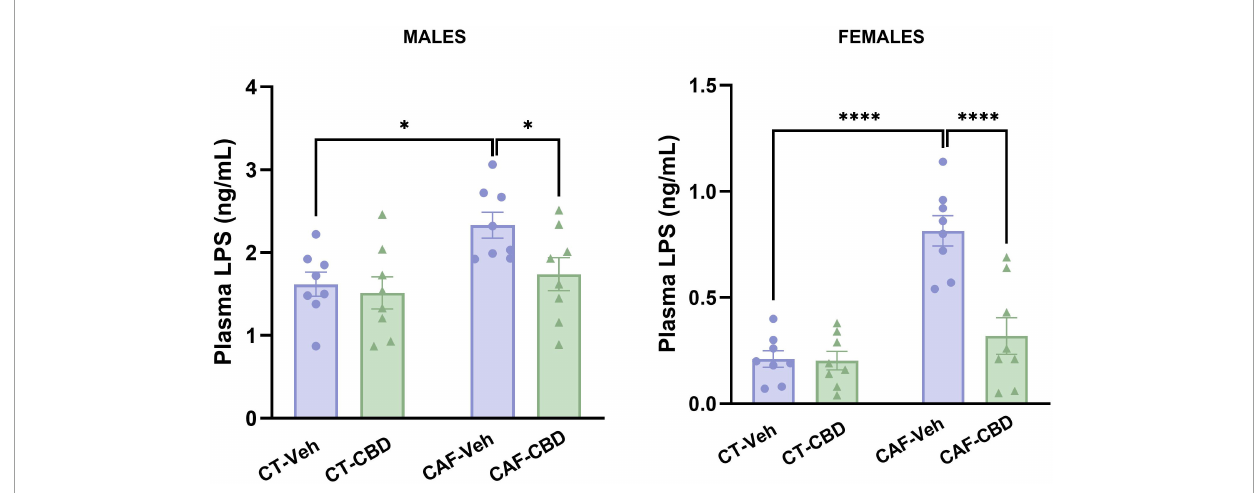
FIGURE6 Plasma levels of lipopolysaccharides (LPS) of the offspring. Maternal obesity increased circulating LPS in both males and females, but cannabidiol (CBD) treatment was able to decrease its levels. Data are presented as mean ± SEM. n = 8–10/group. ∗ p < 0.05 ∗∗∗∗ p < 0.0001.